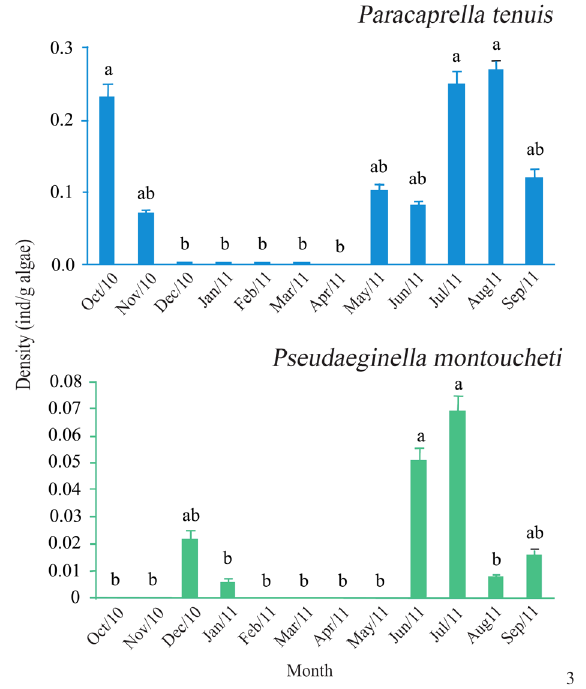
Figure 5. Monthly values of juvenile density (ind./g of algae) (mean ± standard error) of Paracaprella tenuis and Pseudaeginella montoucheti from October 2010 to September 2011.